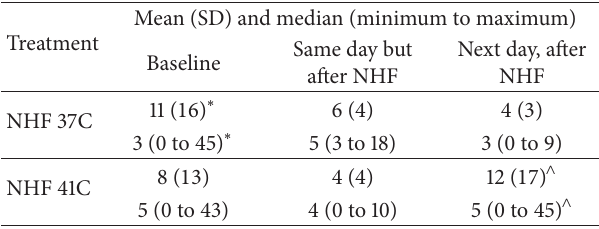
Table 3: Saccharin test times.